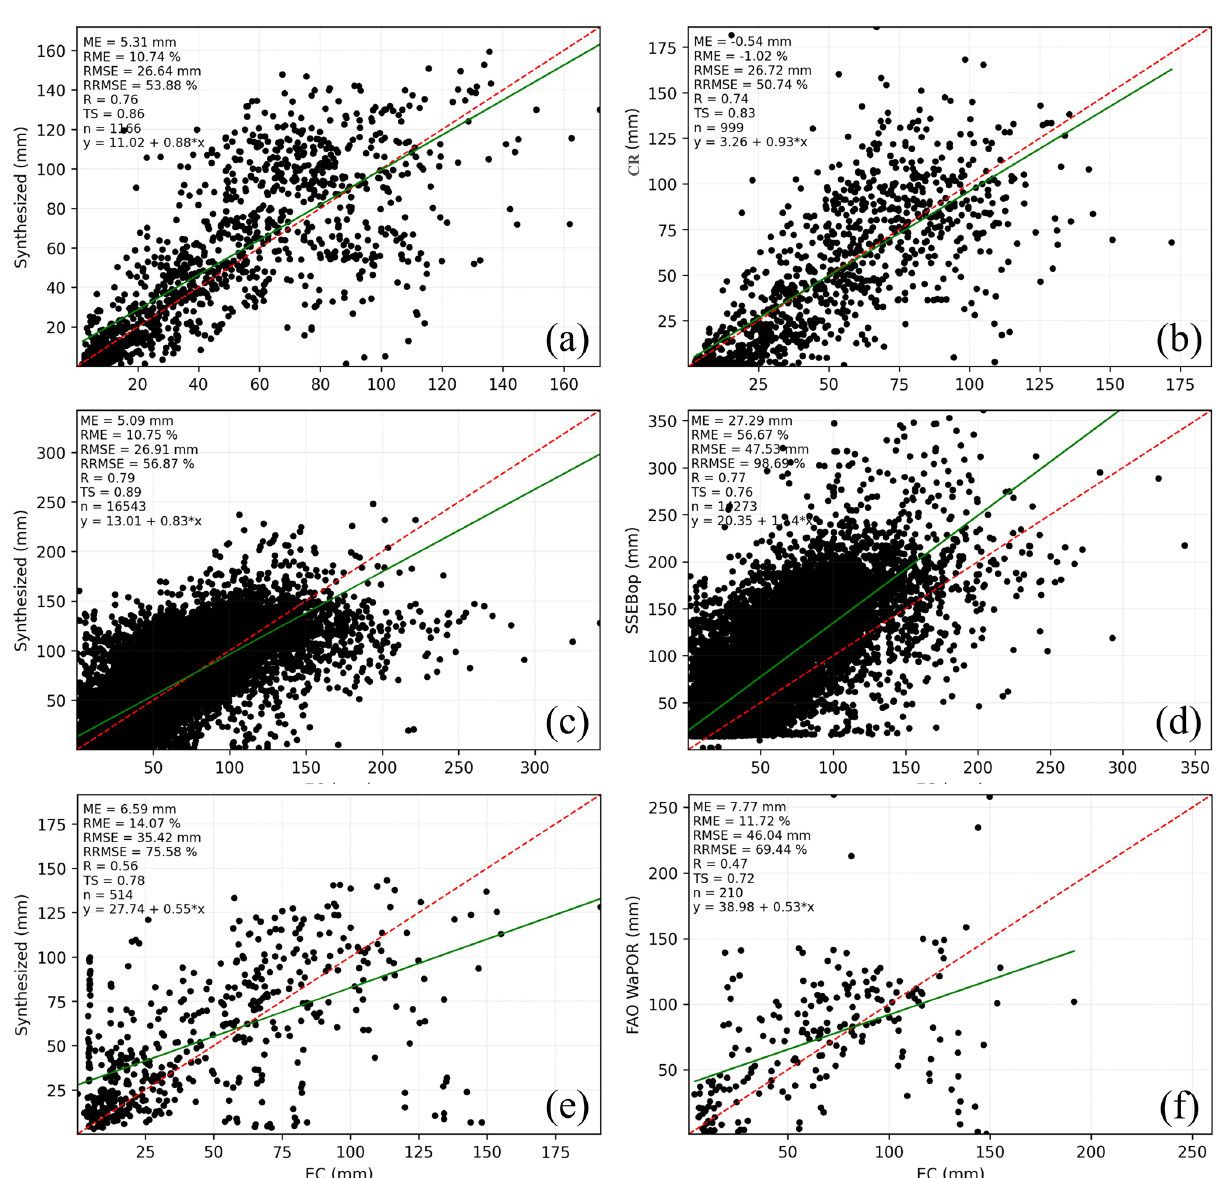
Figure 19. Monthly comparison between the synthesized ET (a, c, e) and CR (b) , SSEBop (d) , and FAO WaPOR (f) ET products against flux EC ET aggregated for all sites over China (a, b) , the USA (c, d) , and the African continent (e, f)